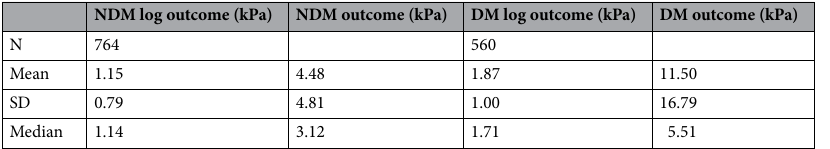
Table 2. Adipose tissue moduli statistics. N number of data points measured, SD standard